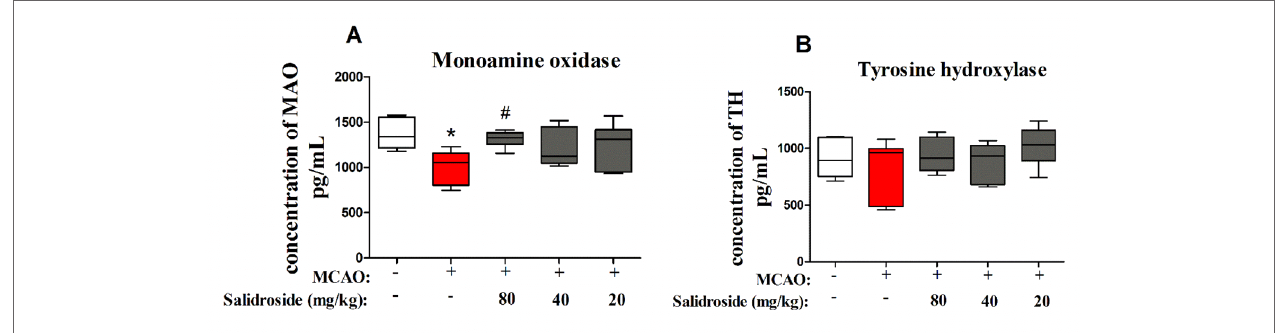
FIgURE 5 | Salidroside treatment modulates MAO in the serum of MCAO-induced rats. Salidroside (20, 40, and 80 mg/kg) or vehicle was i.p. administered before the surgery. After the microdialysis procedure, the levels of MAO (a) and TH (B) were determined using ELISA. Data are presented as the mean ± SEM ( n = 7 rats per group). * p < 0.05 compared with the sham group; # p < 0.05 compared to the MCAO group. MAO monoamine oxidase, TH tyrosine hydroxylase, MCAO middle cerebral artery occlusion, ELISA enzyme-linked immunosorbent assay, SEM standard error of the